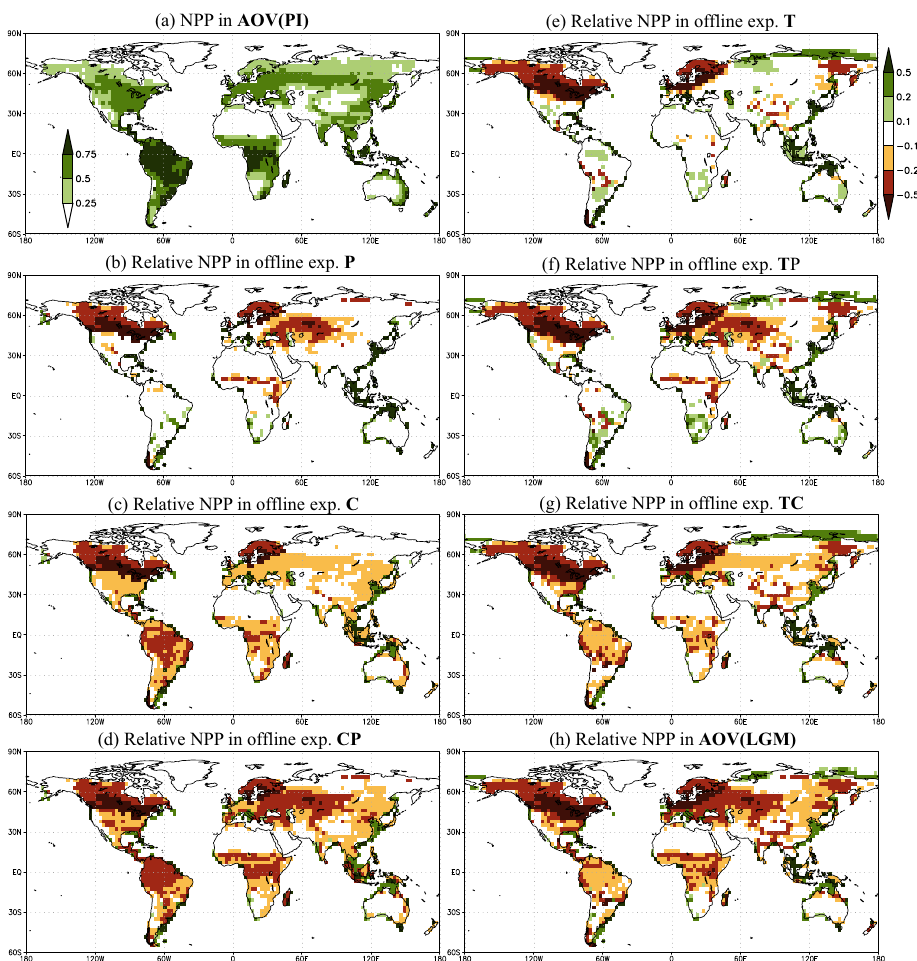
Fig. 3. Equilibrium net primary productivity (NPP) [kgm − 2 yr − 1 ] in (a) AOV(PI) and absolute NPP differences with respect to AOV(PI) in offline experiments (b) P , (c) C , (d) CP, (e) T , (f) TP and (g) TC. Absolute NPP difference in AOV(LGM) with respect to AOV(PI) is shown in (h).